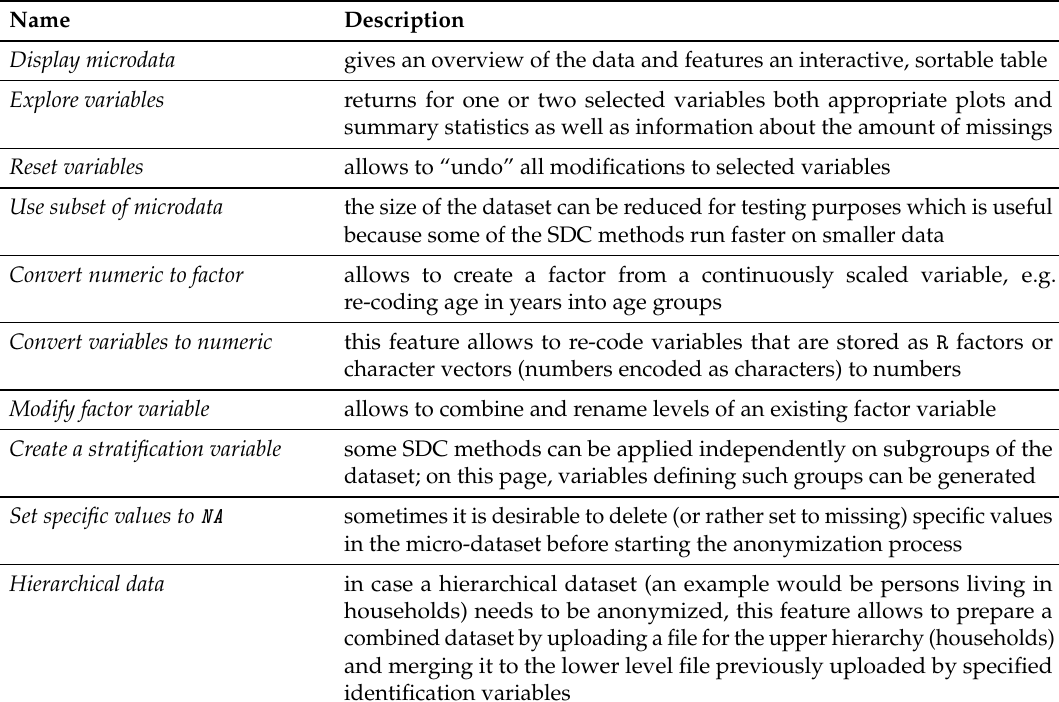
Table 2. Interactive features to update, view, and